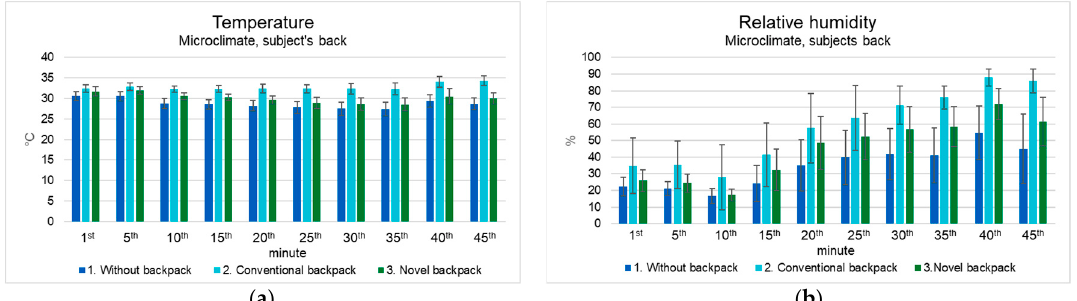
Figure 2. Temperature ( a ) and relative humidity ( b ) for the three test conditions at different time intervals during the protocol. Mean ± SD of the three sensors placed in the microclimate along the spine.